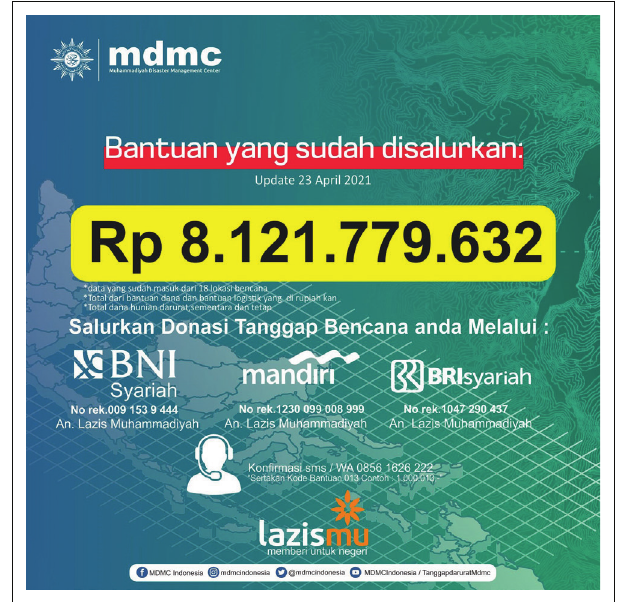
FIGURE 5: Aid that has been distributed on 23 April